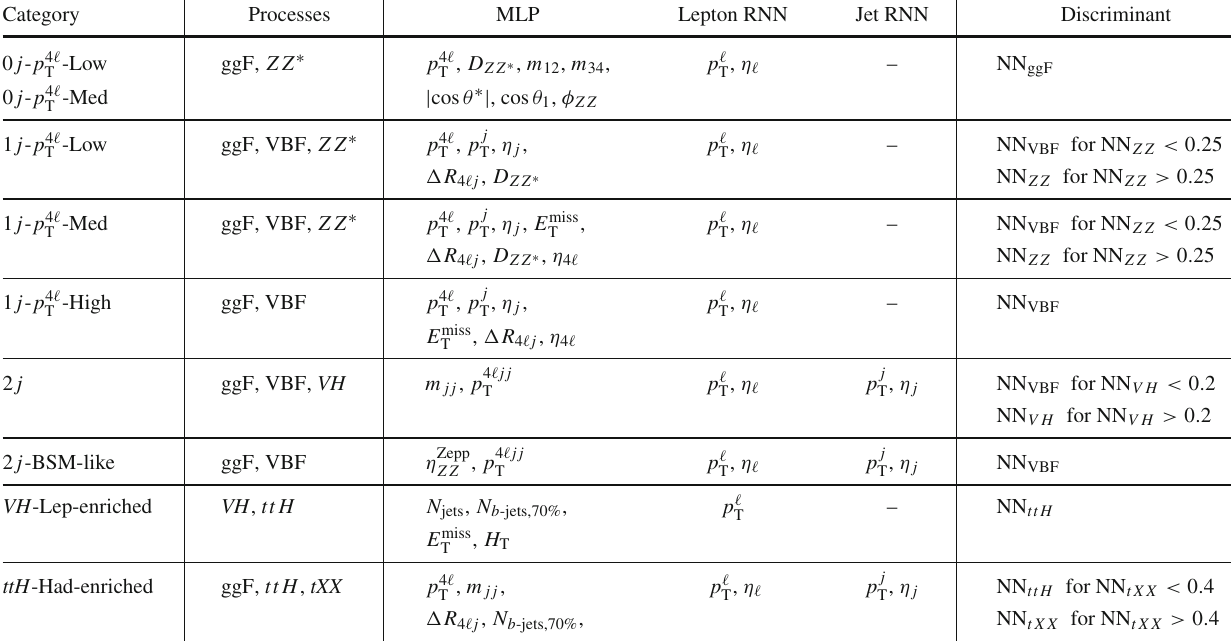
eight input variables for the Lepton RNN being trained if p (cid:4) and η (cid:4) are T listed. Leptons and jets are denoted by ‘ (cid:4) ’ and ‘ j ’. See the text for the definitions of the